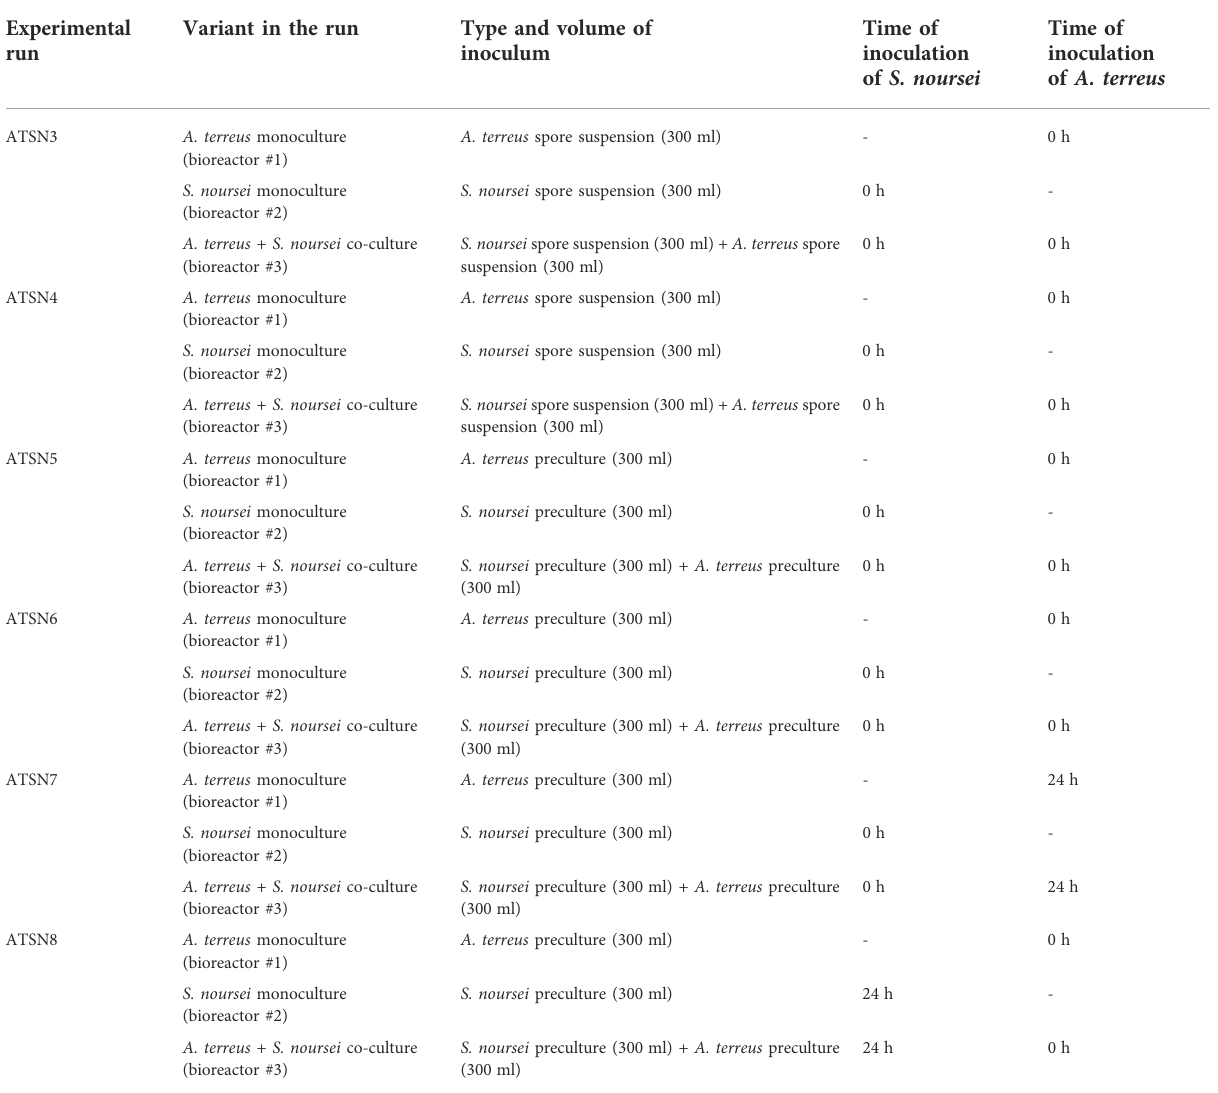
TABLE 1 Inoculation strategies used in the study. Experimental